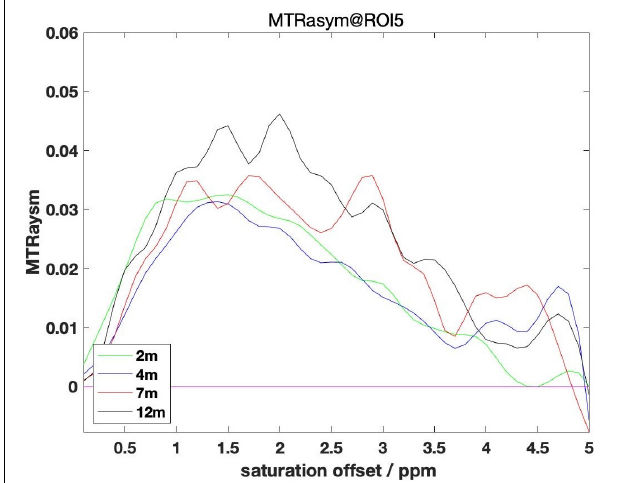
FIGURE 4 | Comparisons between different month age groups of ROI